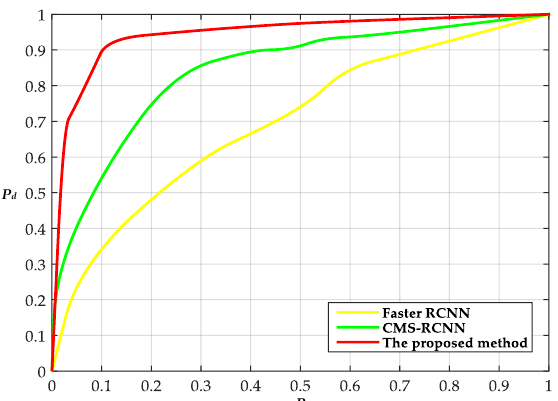
Figure 7. The performance curves of different methods. The yellow, green and red curves represent the performance of Faster RCNN, CMS-RCNN and the proposed method respectively. The x label and y label represent p f and p d